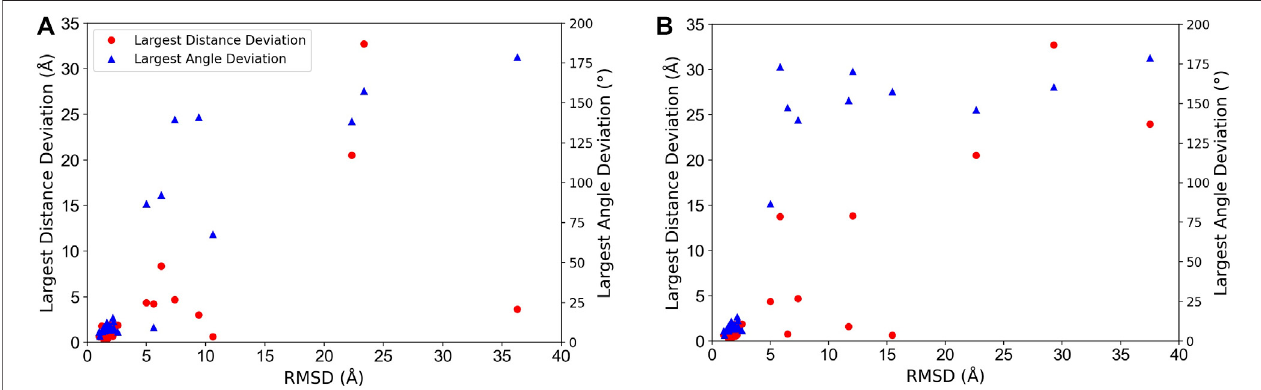
FIGURE 3 | Relationship between overalls RMSD of protein complex models and distance and angle deviation of subunits. The worst (largest) deviations among subunitswereplotted.Redcircles,distancedeviation;bluetriangles,angledeviation. (A) Thebestmodelamongthetop10-scoredmodelswasconsidered. (B) Thetop- scored models were considered.